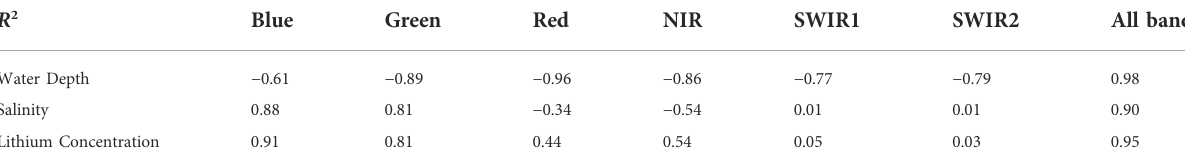
TABLE 3 The correlation between the re fl ectance of Landsat imagery and the measured spectral value in single band and all bands. R 2 Blue Green Red All bands Water Depth Salinity Lithium